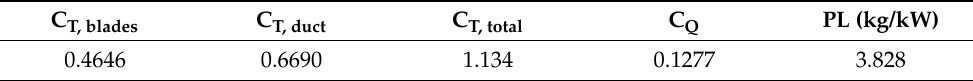
Figure 11. Variation in ducted fan performance with height: ( a ) thrust ratios; ( b ) torque and power loading ratios. Table 5. Aerodynamic performance of ducted fan when hovering out of ground